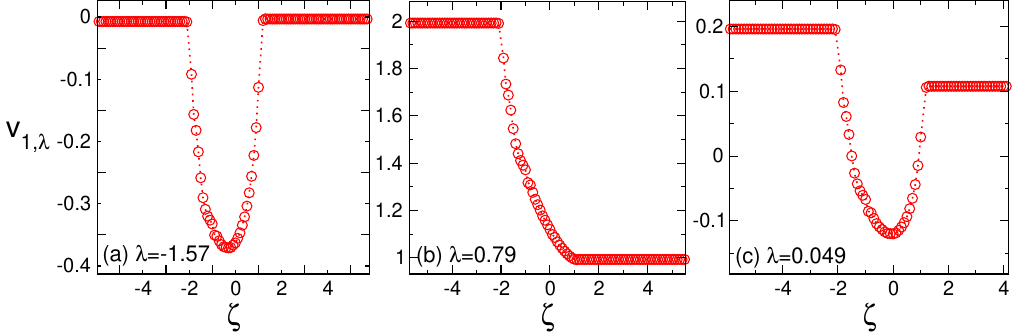
Figure 2: Velocity field v α after a quench in the XXZ chain for ∆ = 10, plotted , λ against ζ ≡ x / t . The pre-quench initial state is obtained by joining the Néel state | N,0 〉 (24) (left) and the ferromagnet | F,0 〉 (25) (right). Here we only show results for α = 1. Different panels correspond to different values of rapidity λ . Note that for ζ < v min ≈ − 2 and ζ > v max ≈ 1 the velocity field does not depend on ζ , as